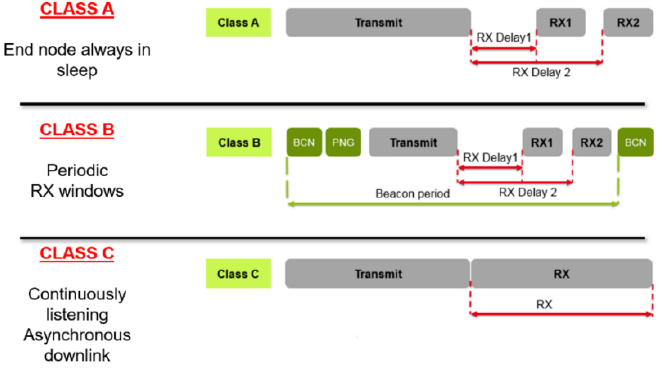
Figure 2. Three terminal operation modes of Lora[19].